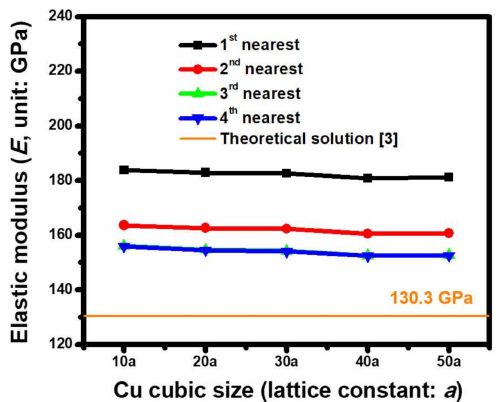
Figure 6. Size dependence of E for the Cu(110) crystal estimated by utilizing ACM-based FEA when the Morse parameters of set 5 are considered ( a = 3.61 Å).